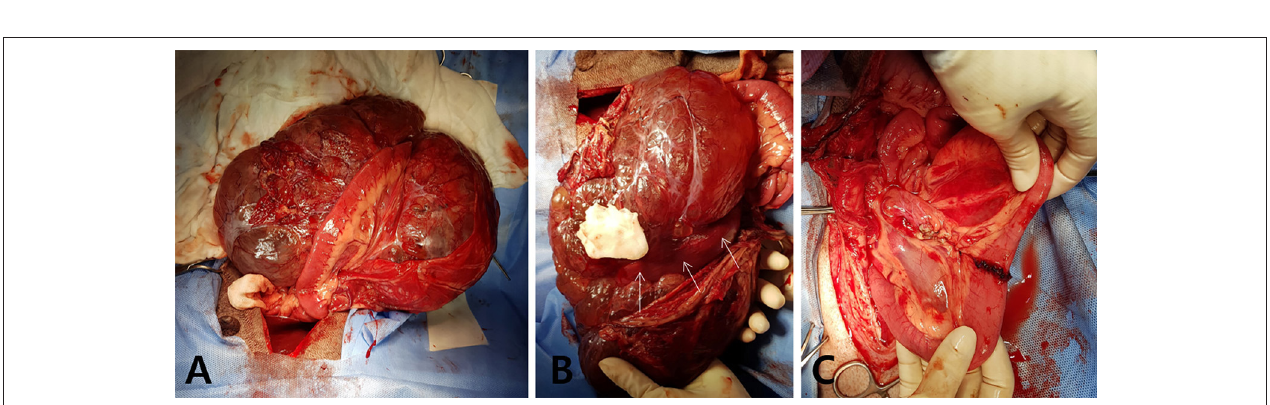
FIGURE 1 | Diagnostic images at presentation. Dorsoventral (A) abdominal radiographs revealed a large soft tissue opacity located at the mid abdomen (white arrows). Post-contrast dorsal (B) and transvers (C) computed tomography scanning images of the mass (yellow dotted line, size of 29 × 19 × 11cm). Connections between the cavity within the mass and the intestinal lumen represent the presence of fistulation (yellow arrow).